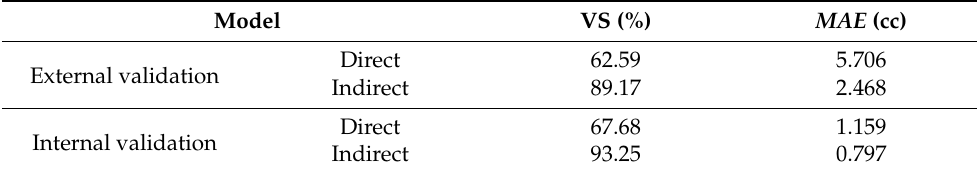
Table 3. AIS Volume estimation results for internal validation and external validation.